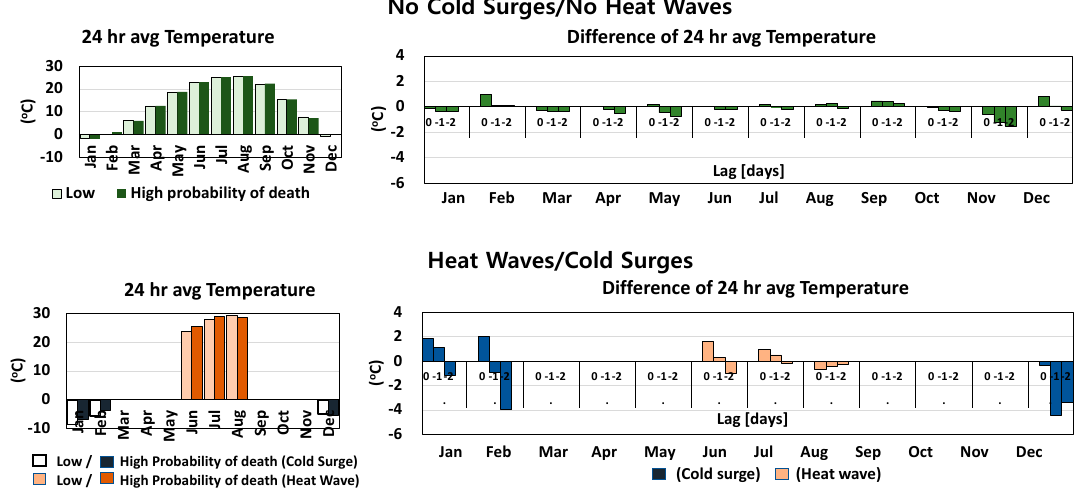
Figure 12. Comparison of monthly average temperatures on days of high and low probability of death and the differences in temperatures (temperature (high probability of death) –temperature (low probability of death) ) from zero to two days before death.